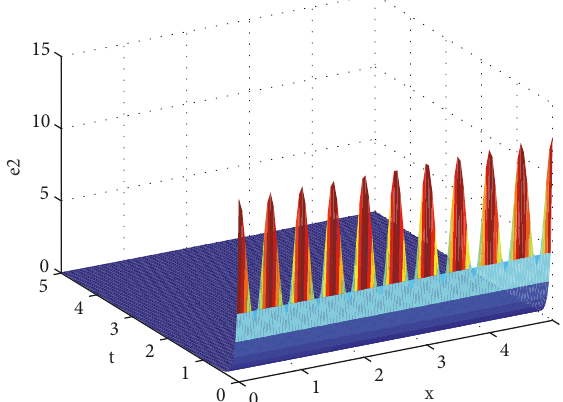
Figure 6: Time evolution of the nonlinear synchronization control error 𝑒 2 .